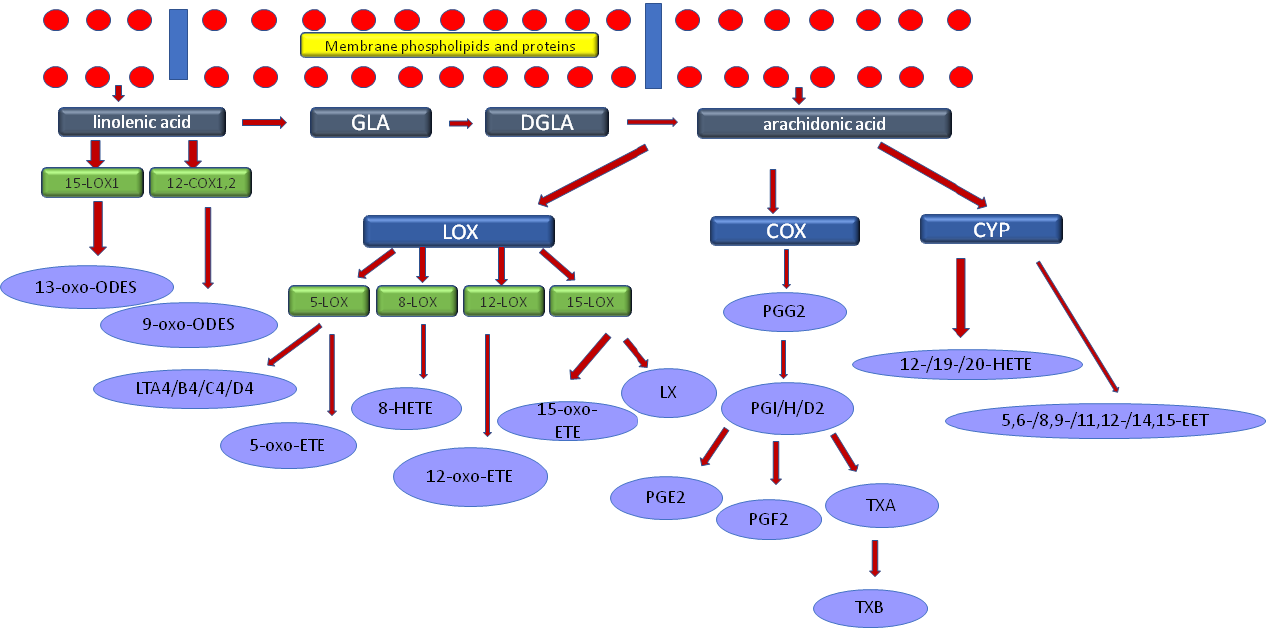
Figure 1. The cascade of linolenic acid metabolism. Legend: GLA-C18:3n6 gamma linoleic acid, DGLA-dihomo- γ -linolenic acid (C20:3n6 eicosatrienoic acid), LOX-lipoxygenase, COX-cyclooxygenase, CYP-cytochrome, LT-leukotriene, LX-lipoxin, PG-prostaglandins, TX-thromboxan. Linolenic acid was negatively correlated with the results of CVLT test, while GLA and AA were directly associated.